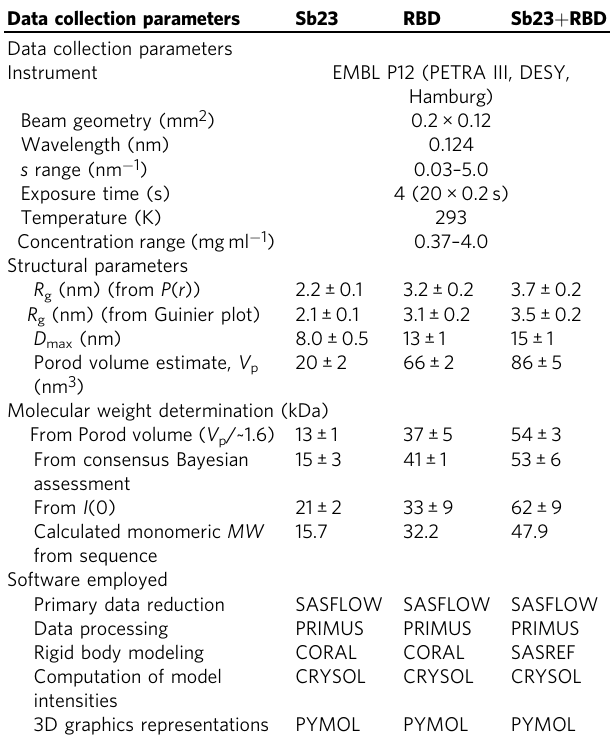
Table 1 Data collection and structure statistics for SAXS